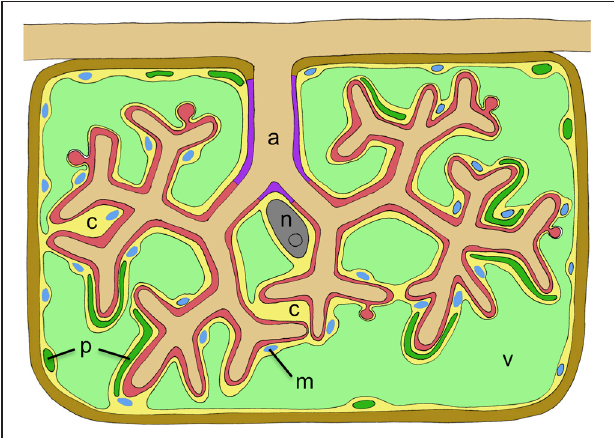
FIGURE 2 | Schematic representation of a cortex cell with an arbuscule. The arbuscule takes most of the space that is normally occupied by the central vacuole. Cellular compartments are colored in light green (plant vacuole), dark green (plant plastids), blue (plant mitochondria), yellow (plant cytoplasm), gray (nucleus), red (symbiotic interface), purple (trunc portion of the symbiotic interface), and brown (plant cell wall). The cellular constituents of the host are marked with letters as follows: c, cytoplasm; m, mitochondria; n, nucleus; p, plastids; v, vacuole. The fungal arbuscule is marked as well